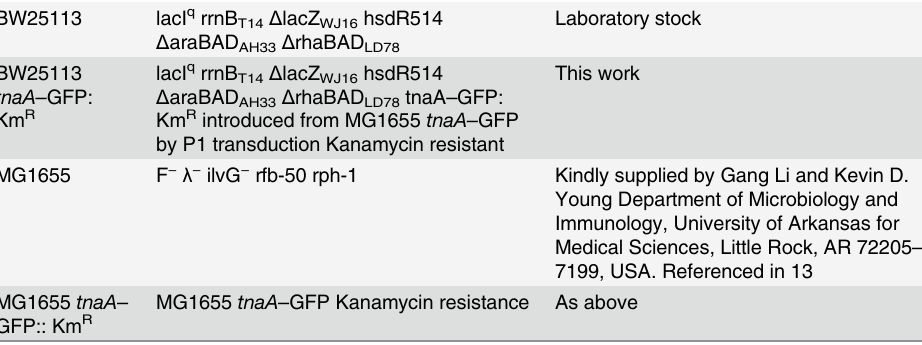
Table 1. List of E . coli strains used in this